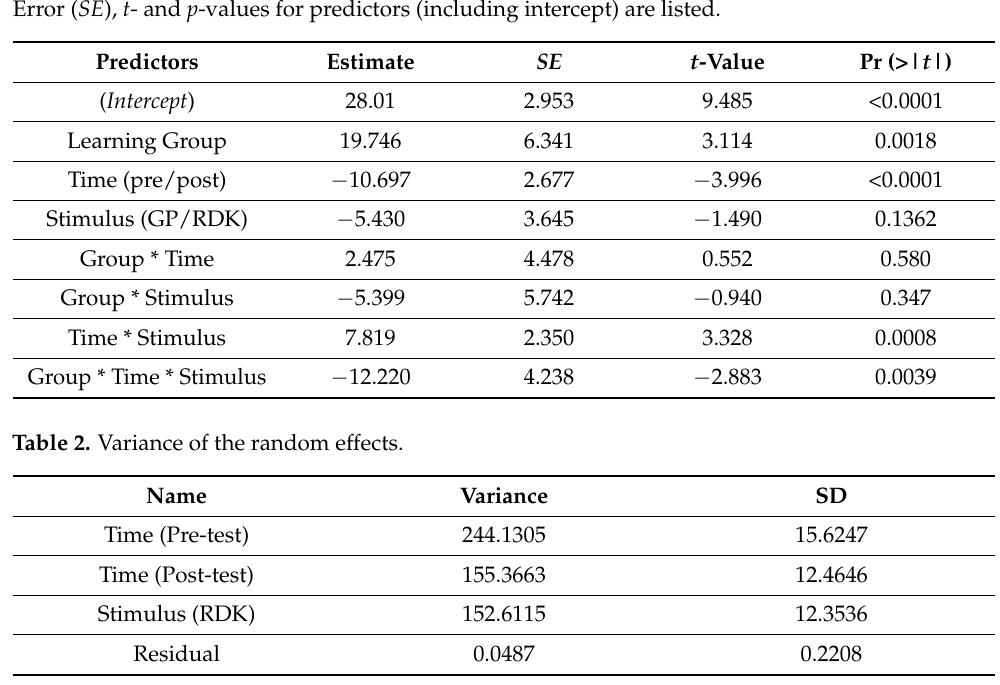
Table 1. Estimated coefficients of the best fitting generalized linear mixed model (GLMM). Standard Error ( SE ), t - and p -values for predictors (including intercept) are listed.